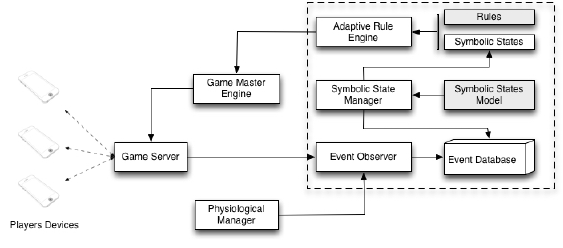
Figure 2. The Plug